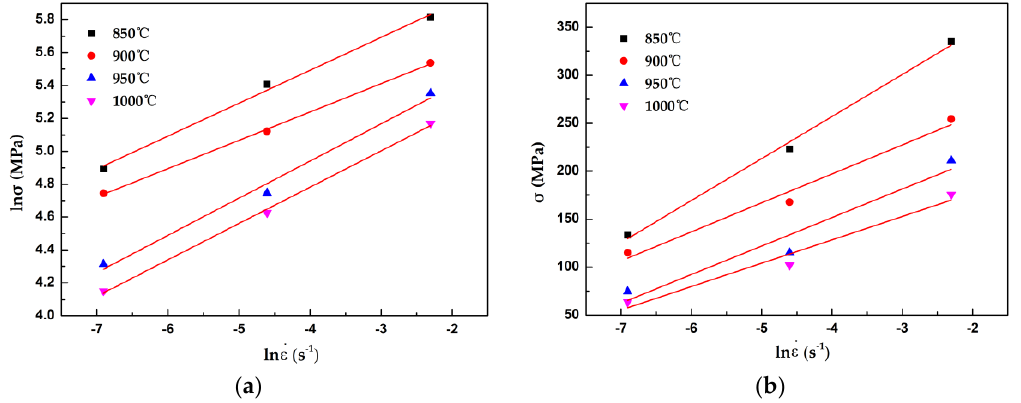
Figure 4. Plot of ( a ) lnσ–ln ε and ( b ) σ–ln ε for calculating β and n at different deformation temperatures. It is important to note that flow stress is taken at ε = 0.8.